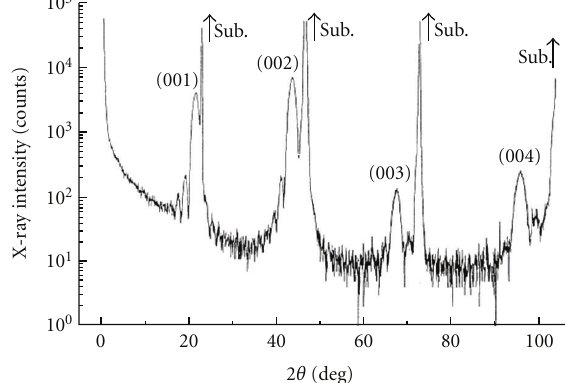
Figure 6: X-ray di ff raction profiles along the [0 0 l ] direction of the BaTiO 3 thin films with 60 ˚A on SrTiO 3 substrate (monochro- matized CuK α ). Subscript “Sub” means reflections from SrTiO 3 substrate [24].